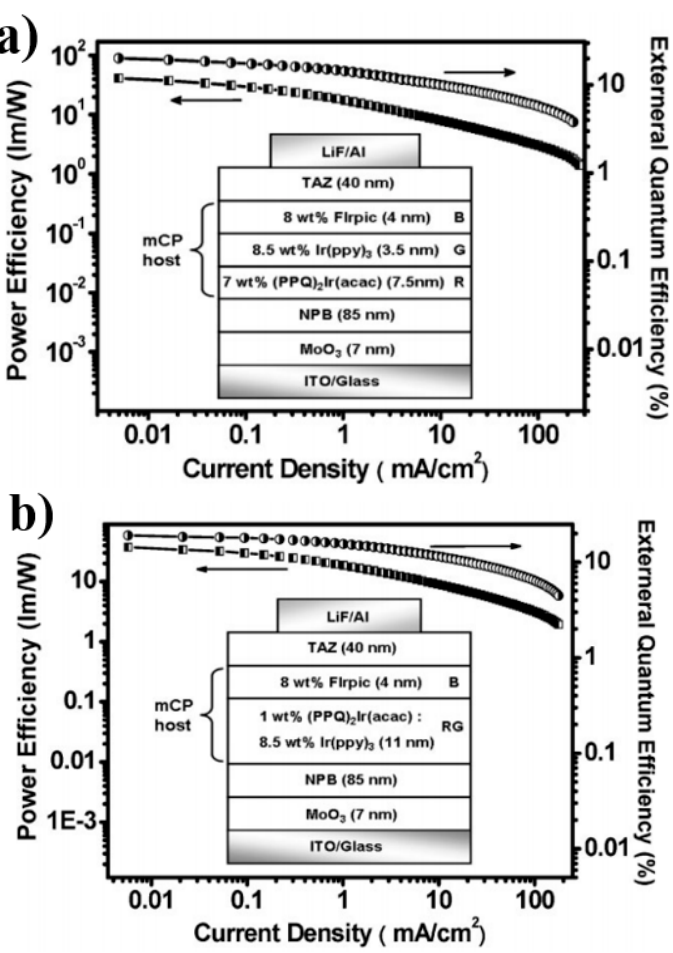
Figure 12. The WOLED architecture/efficiency of ( a ) the first device; ( b ) the second device. Reproduced from Reference [135].